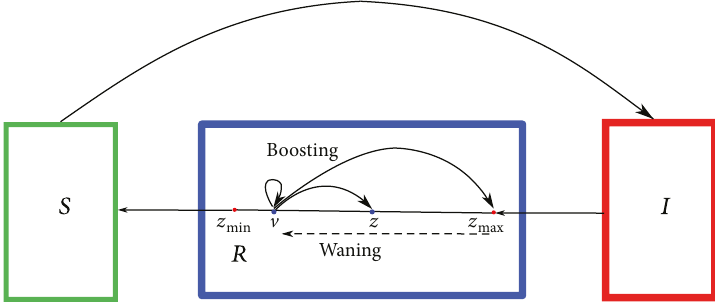
Figure 1: Sketch of the mathematical models (3), (4), and (5). Susceptible hosts become infective after pathogen transmission. Infected hosts who recover enter the immune compartment R which is structured by the level of immunity. Natural infection induces the maximal level of immunity z max . Immunity decays in time and when the immune status reaches the minimal value z min ; the recovered host becomes susceptible again. Meanwhile, exposure to the pathogen can boost the immune system and prolong